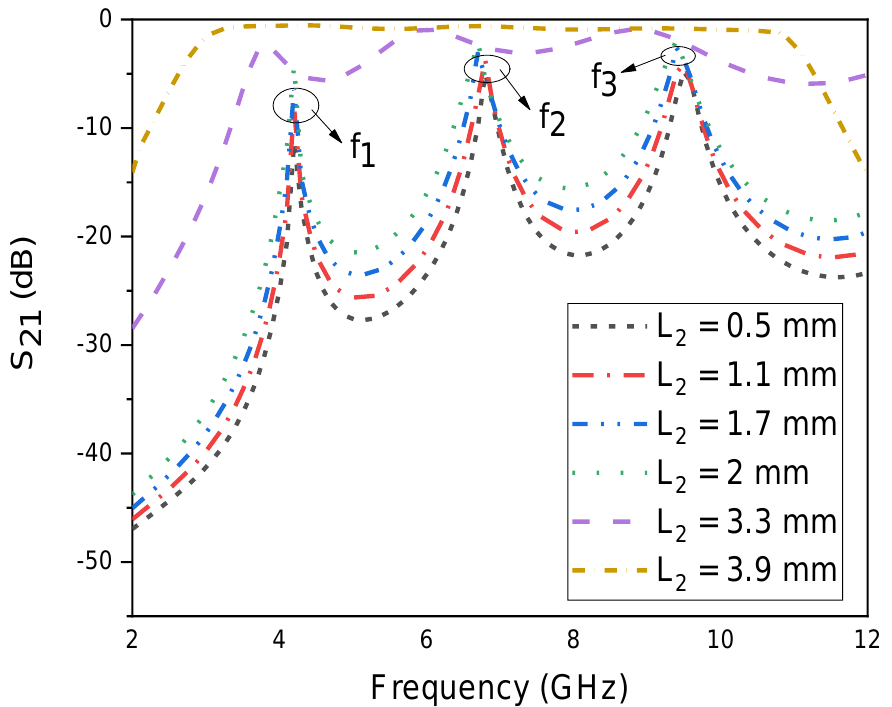
Figure 9. The magnitude of | S 21 | under different coupling scheme w.r.t parameter L 2 . Now, the attention is shifted to how notched bands are formed in the ultrawide pass- band filter. As discussed above, the two stopbands are formed by the embedded spur line and rectangular stub resonator coupled to the middle section of the proposed multimode resonator structure with the gap G = 0.3 mm. The first notch band for eliminating the fre- quency at 3.5 GHz was obtained due to the rectangular stubs coupled to the main trans- mission line, while the second notch band obtained for eliminating the frequency at 7.5 GHz was due to the L-shaped spur line structure, as shown in the Figures 10 and 11, re- spectively. The first stopband was obtained when the gap between the rectangular stub resonator and the multimode resonator was kept small. Thus, the first stopband appeared when the rectangular stub resonator was strongly coupled to the multimode resonator with a gap G = 0.3 mm. As shown in Figure 10, when the gap increased from 0.3 mm to 0.5 mm, the first stopband peak vanished and went towards − 10 dB.